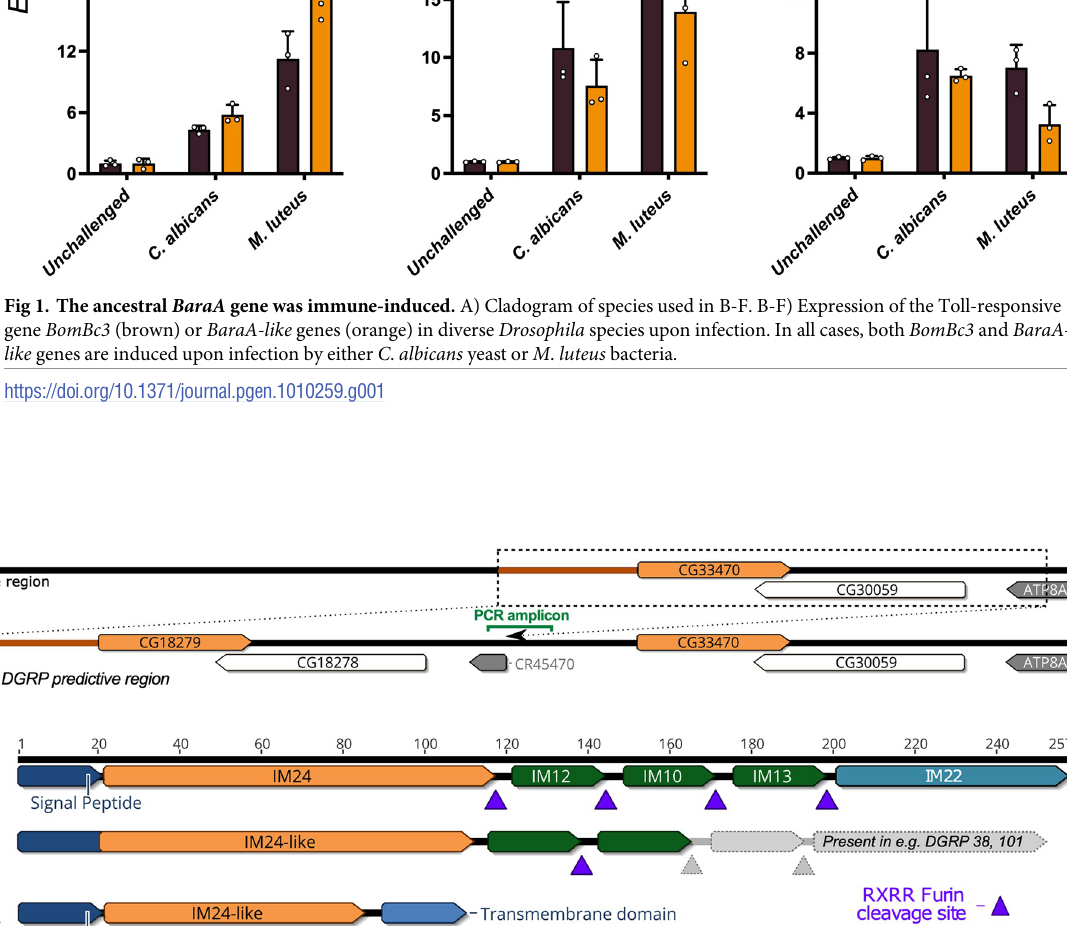
PLOS Genetics | https://doi.org/10.1371/journal.pgen.1010259 June 17,